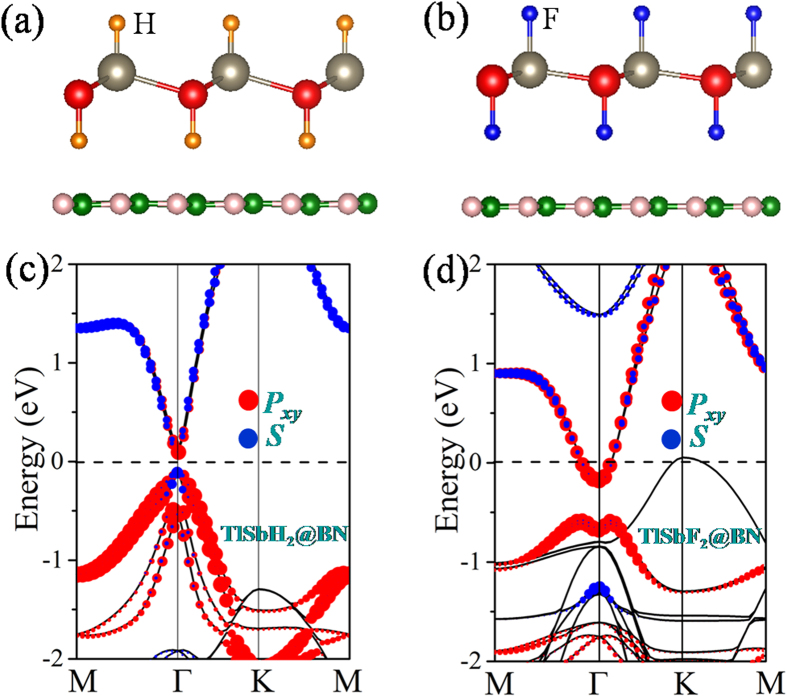
Crystal structures of TlSbX2 grown on BN substrate from the top and side view for (a) TlSbH2 and (b) TlSbF2. (c) TlSbH2 and (d) TlSbF2 correspond to the orbital-resolved band structures with SOC.